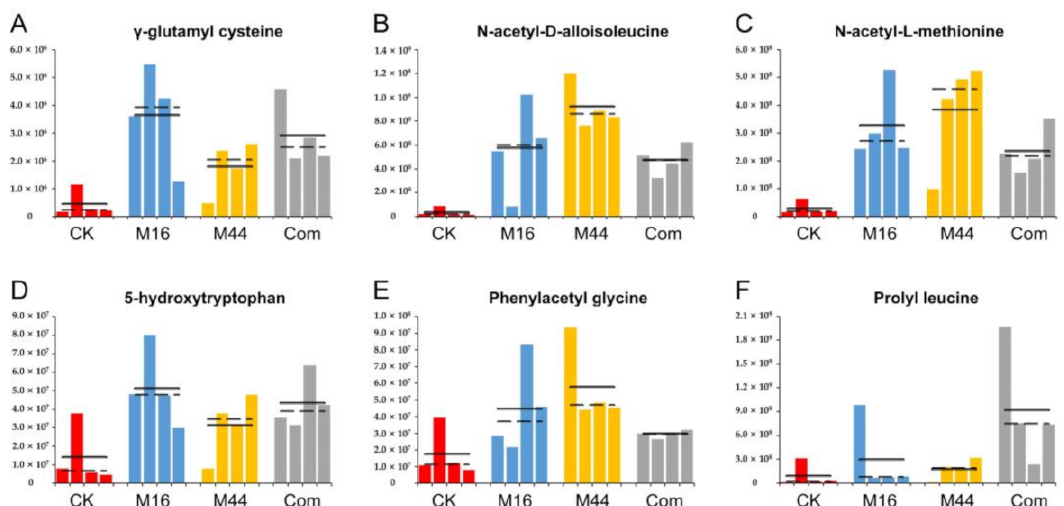
Figure 5. Histograms of differential amino acid derivatives, γ -glutamyl cysteine ( A ), N-acetyl-D-alloisoleucine ( B ), N-acetyl-L-methionine ( C ), 5-hydroxytryptophan ( D ), phenylacetyl glycine ( E ), and prolyl leucine ( F ), based on quan- titative statistics. CK: control; M16: M16 treatment; M44: M44 treatment; Com: combination of M16 and M44. Solid and dashed lines represent the means and medians of the contents of metabolites in CK, M16, M44, and Com,